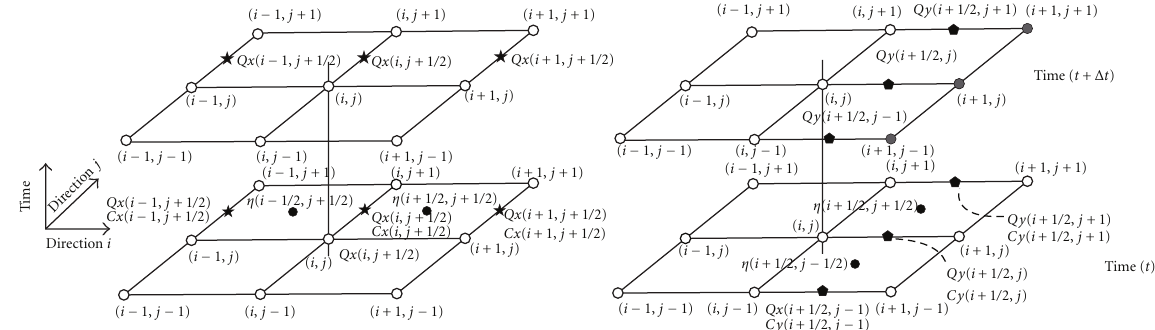
Figure 2: Computational module for the calculation of Qx and Qy .